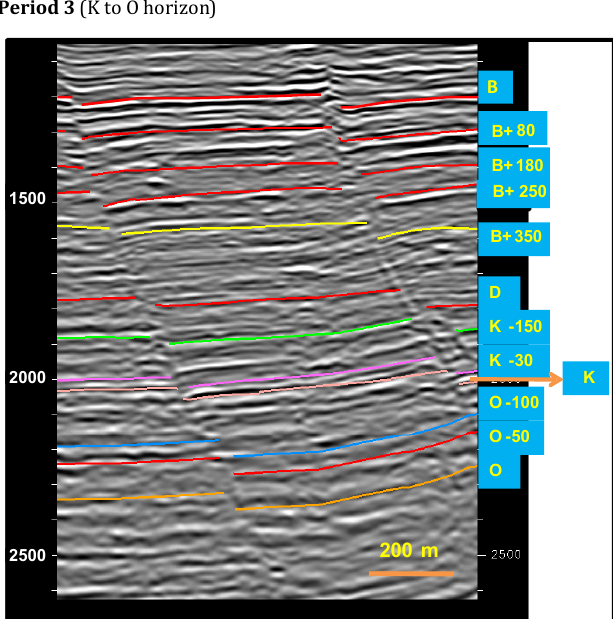
Figure 4: Seismic section showing the interpreted and calculated